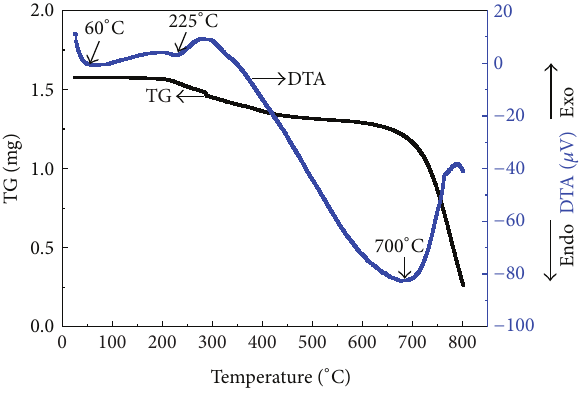
Figure 4: N 2 adsorption-desorption isotherms and pore size distri- bution plots of the MEG samples.